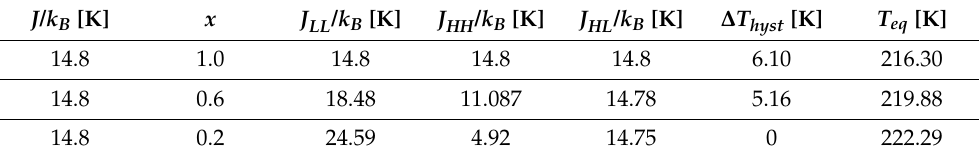
Table 5. Equilibrium temperatures and hysteresis widths calculated for different values of the x = ( J HH / k B ) / ( J LL / k B ) parameter in a 10 × 10 square lattice. The computational parameters are: ∆ / k B = 1300 K, J / k B = 14.8 K, G / k B = 172.2 K and ln( g ) =